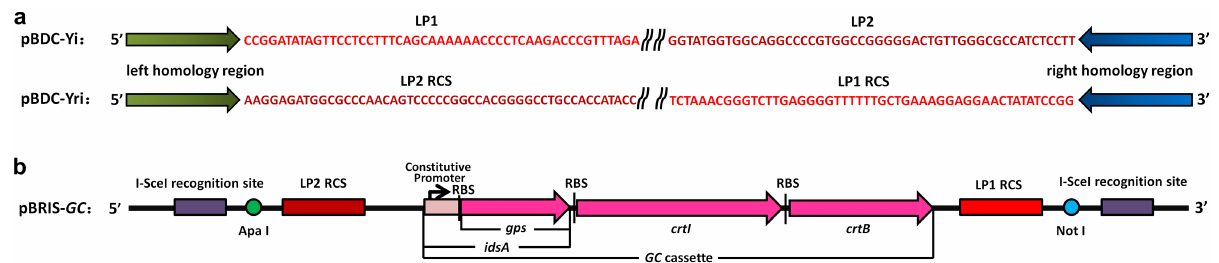
Fig 2. The landing pad plasmid and donor plasmid used for genomic replacement. (a) The landingpad regions of plasmidspBDC-Yi and pBDC-Yri. (b) Linearizedvector map of donor plasmidpBRIS- GC . RCS indicatesthe reverse complementary sequence.